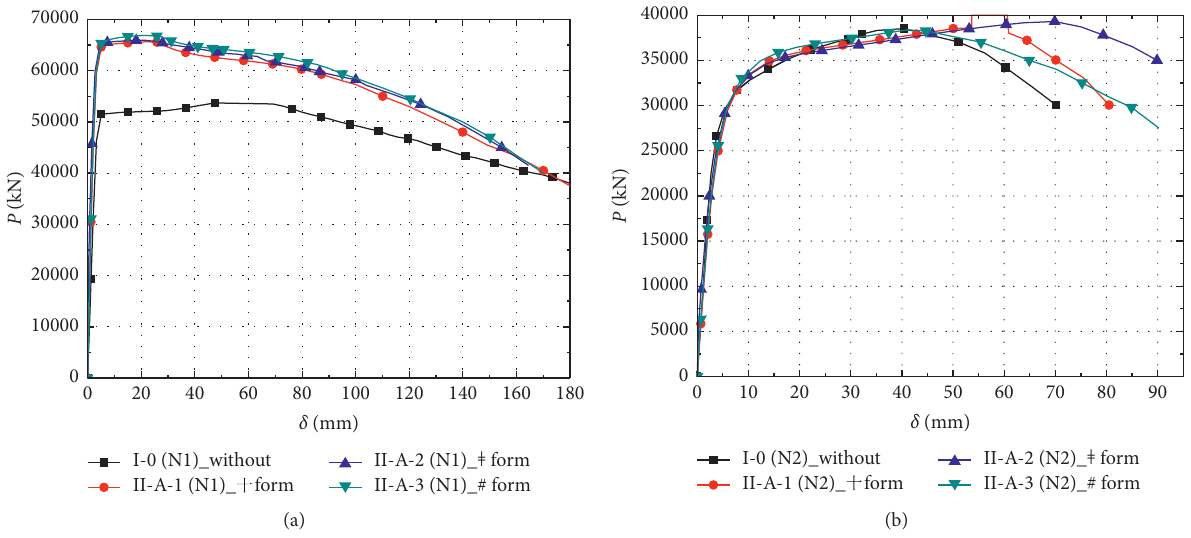
Figure 16: Effects of stiffeners on LYP steel tubular plate. (a) Axially compressed specimens. (b) Eccentrically compressed specimens.